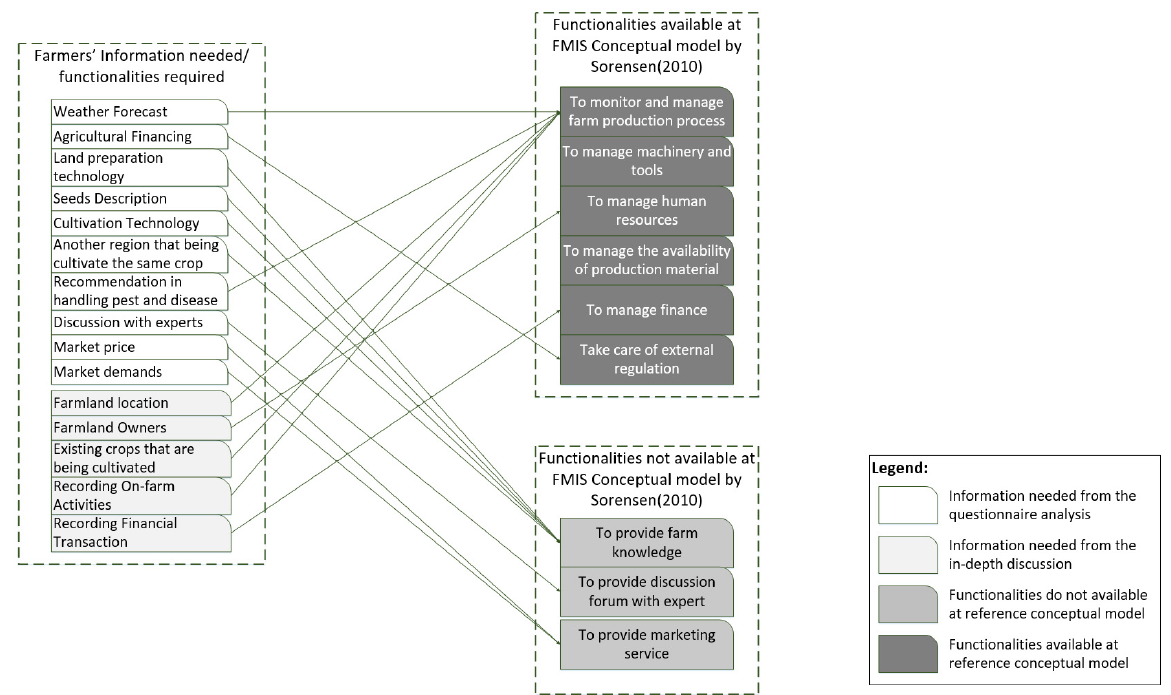
Figure 2. Mapping smallholder farmers’ information needs into the FMIS Conceptual Model.